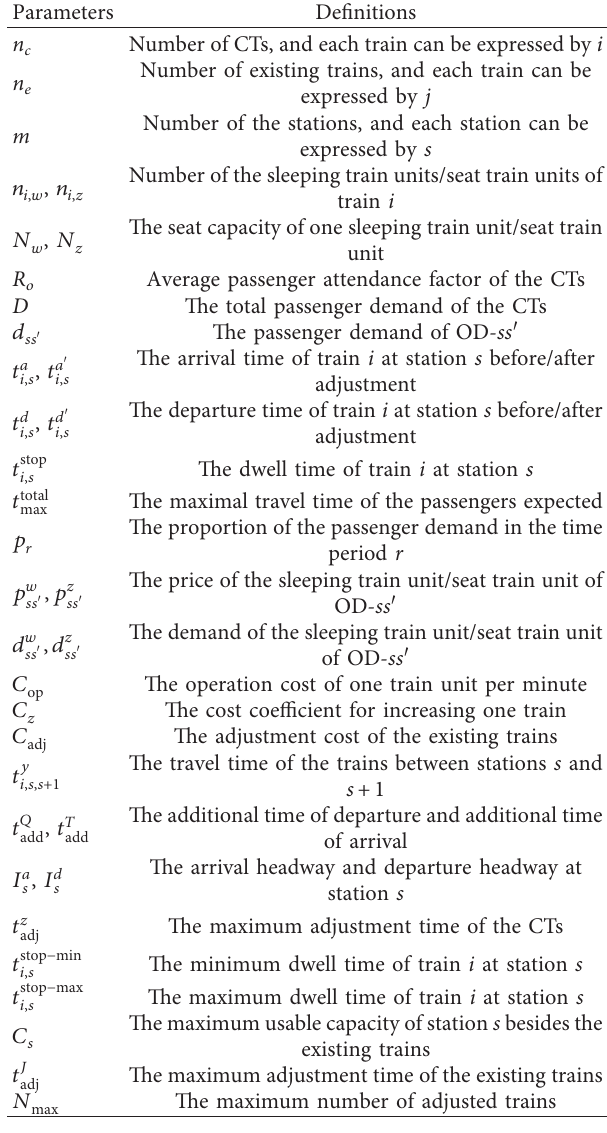
Table 1: Parameters